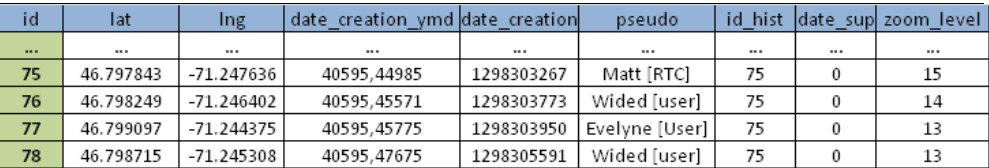
Figure 11. Marker table: object n°75, n°76, n°77 and